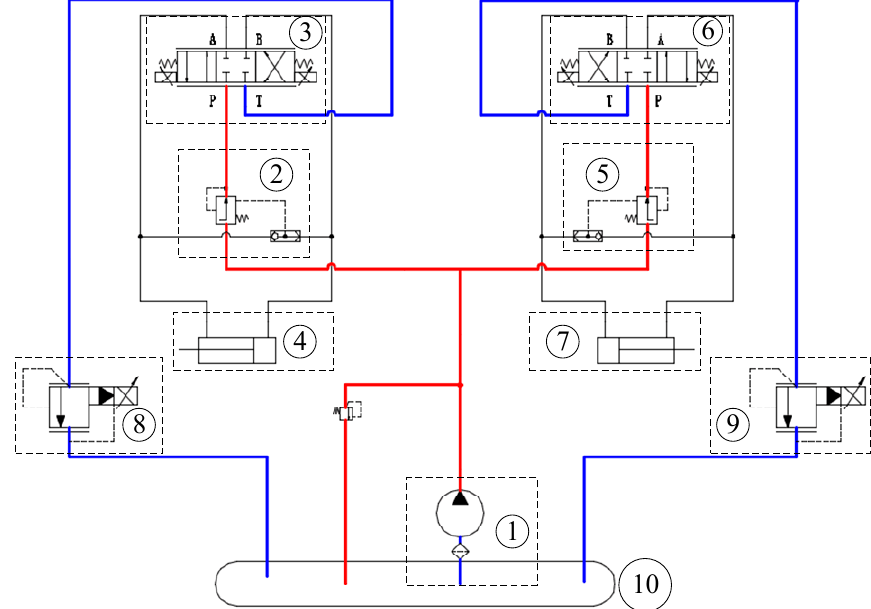
Figure 29. The schematic diagram of hydraulic steering execution module (1—hydraulic pump; 2,5—pressure compensated valve; 3,6—proportional electromagnetic valve; 4,7—steering cylinder; 8,9—relief valve; 10—hydraulic oil tank).